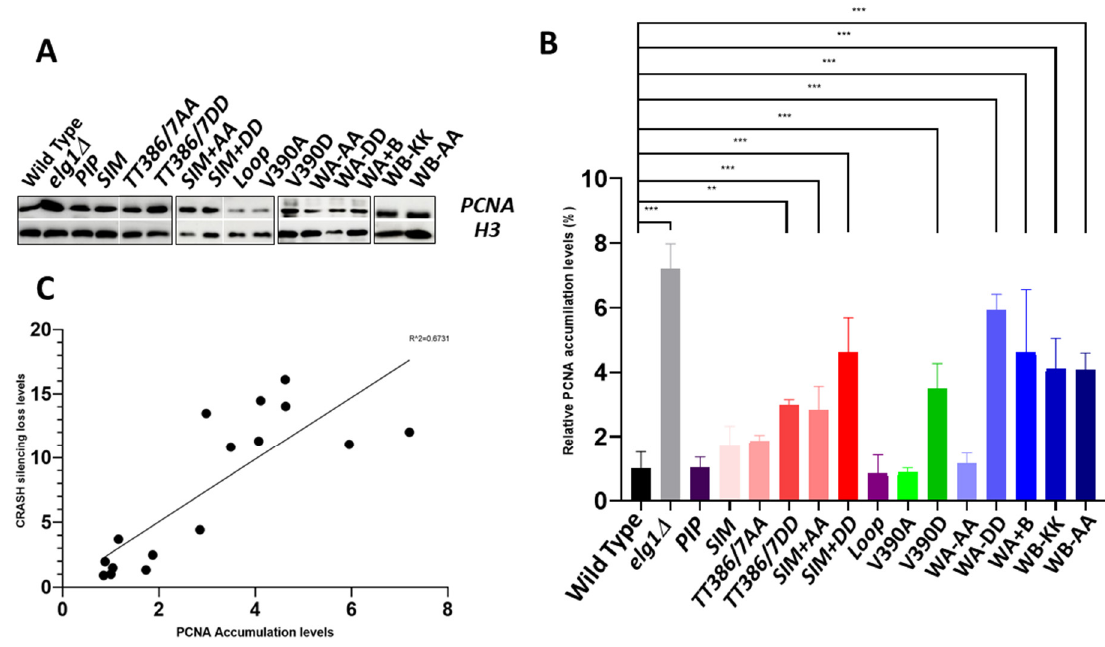
Figure 6. PCNA chromatin levels for the different elg1 mutations. ( A ) A fractionation assay fol- lowed by Western blot to detect PCNA levels on the chromatin in the various elg1 mutants. Histone H3 served as a chromatin-bound- as well as loading control. The full blots are shown as Figure S4. ( B ) Relative levels of silencing loss. At least three experiments were used for quantitation and the error bars represent the standard error of the mean. The graph represents the quantification of Western blots of the relative chromatin-bound PCNA abundance of the different Elg1 mutants in the cell, compared to the relative level of wildtype cells. **, 0.006 > p > 0.001; ***, p < 0.0001; values were calculated using ANOVA and Dunnett’s test post-hoc analysis. ( C ). Correlation between PCNA accumulation and the apparent silencing-loss rate. A correlation is observed between the levels of PCNA and the loss of silencing for each elg1 mutant as measured by the CRASH assay. The R 2 is 0.6731 ( p <